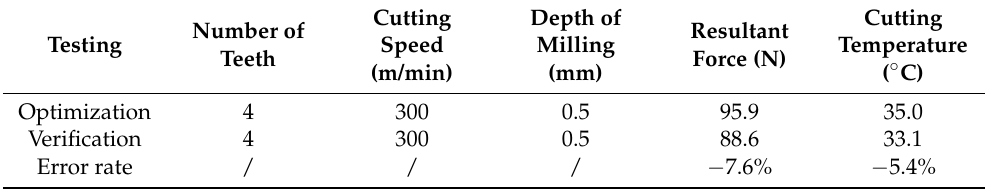
Table 8. Verification of resultant force and